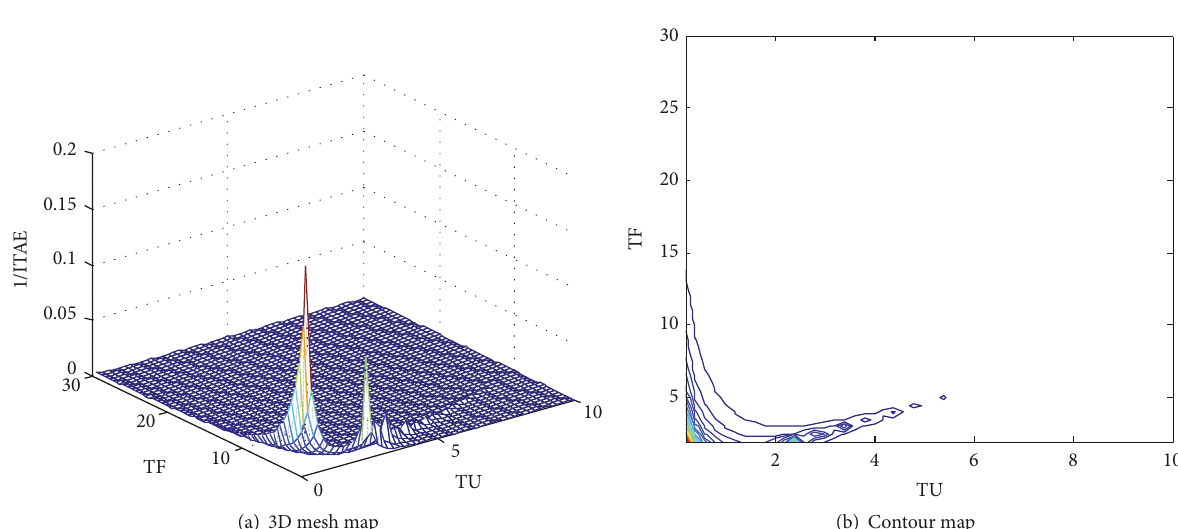
Figure 6: 1/ ITAE of linear handling chain